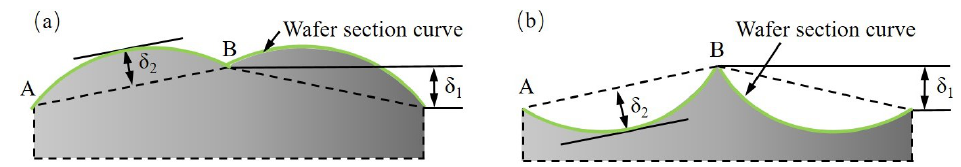
Figure 2. Typical TTV shape and its feature components. ( a ) Type 1: The superposition of cone shape and “M” shape. ( b ) Type 2: The superposition of cone shape and “W”